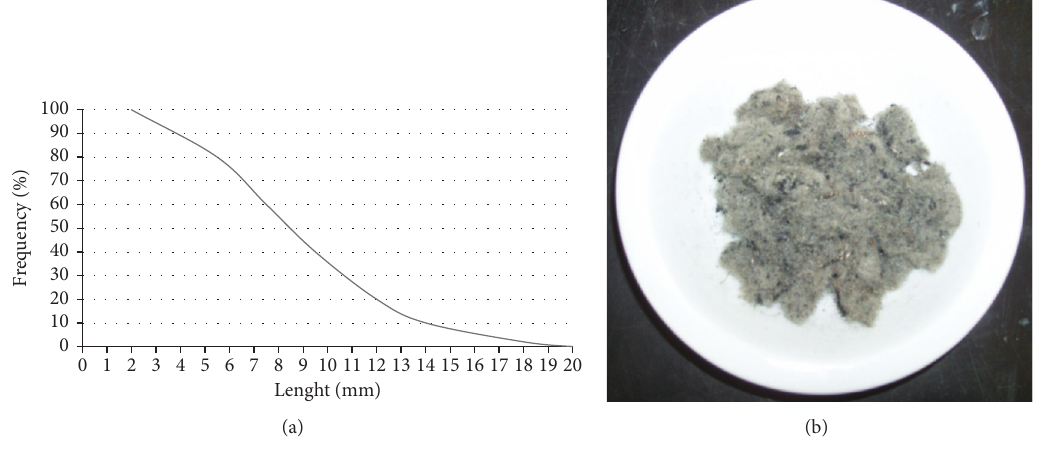
Figure 1: (a) Distribution of length of RTPF. (b) Recycled tyre polymer fibres.